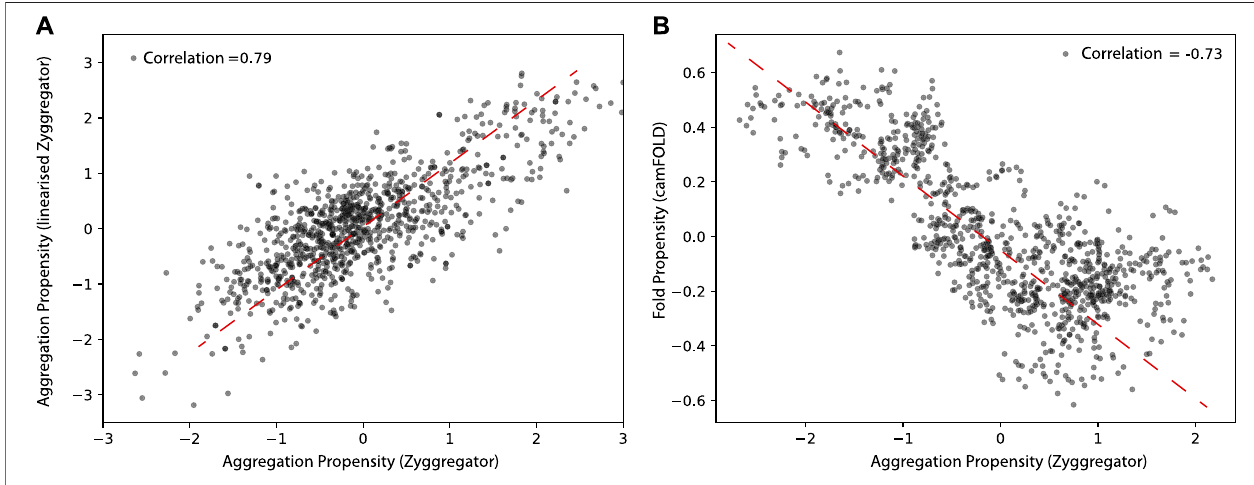
FIGURE 1 | Aggregation and folding propensity of the human proteome. (A) Scatter plot of Zyggregator algorithm and “ linearized ” version computed on 5,000 random proteins from the human proteome. The correlation among the two methods is 0.79, which justi fi es the use of the linear approximation of Zyggregator. (B) Scatter plot of Zyggregator and camFOLD scores. Folding and aggregation propensities are anti-correlated with a Pearson correlation coef fi cient of – 0.73.